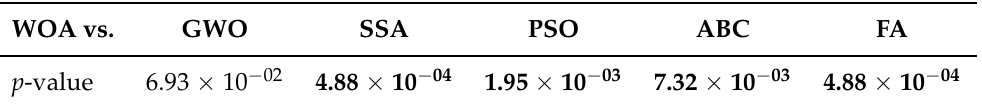
Table 5. Numerical results obtained by Wilcoxon signed-rank test (values below significant level are indicated in